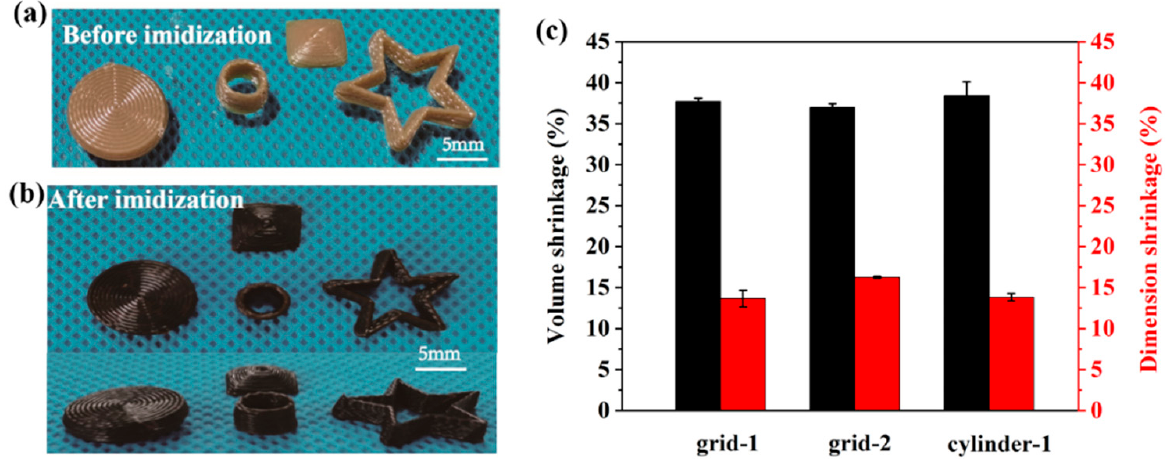
Figure 6. ( a , b ) Examples of printed structures before and after heat treatment; ( c ) the volume and dimensional shrinkage of the printed structures.